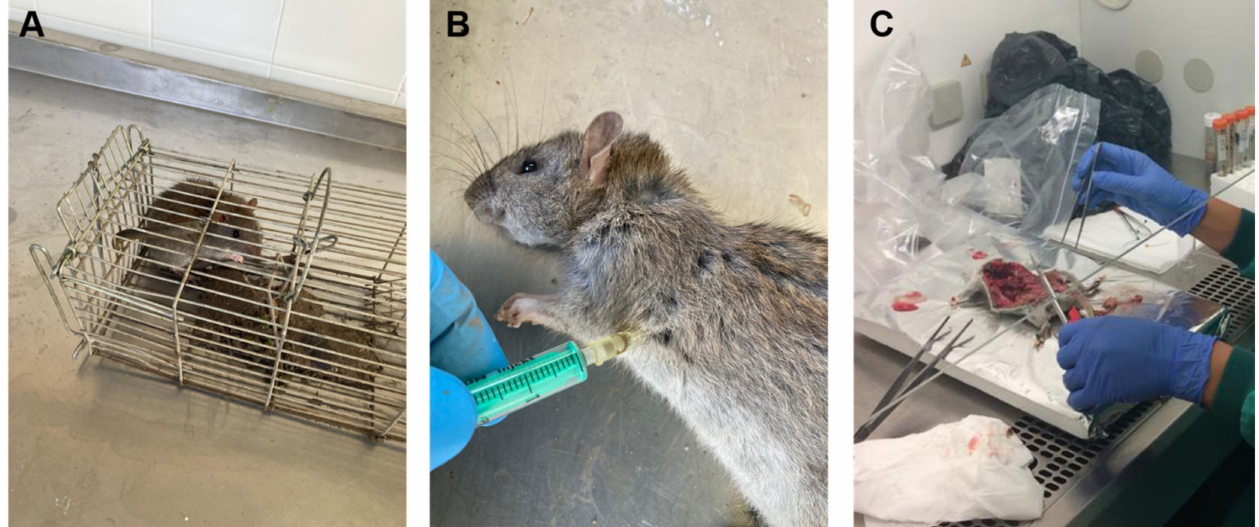
Figure 1. Sampling of rodent specimens within the premises of the C ó rdoba Zoo Conservation Centre. ( A ): Capture using live traps; ( B ): Humanely killing by intracardiac injection of sodium pentobarbitone; ( C ): Dissection of rat carcasses and organ